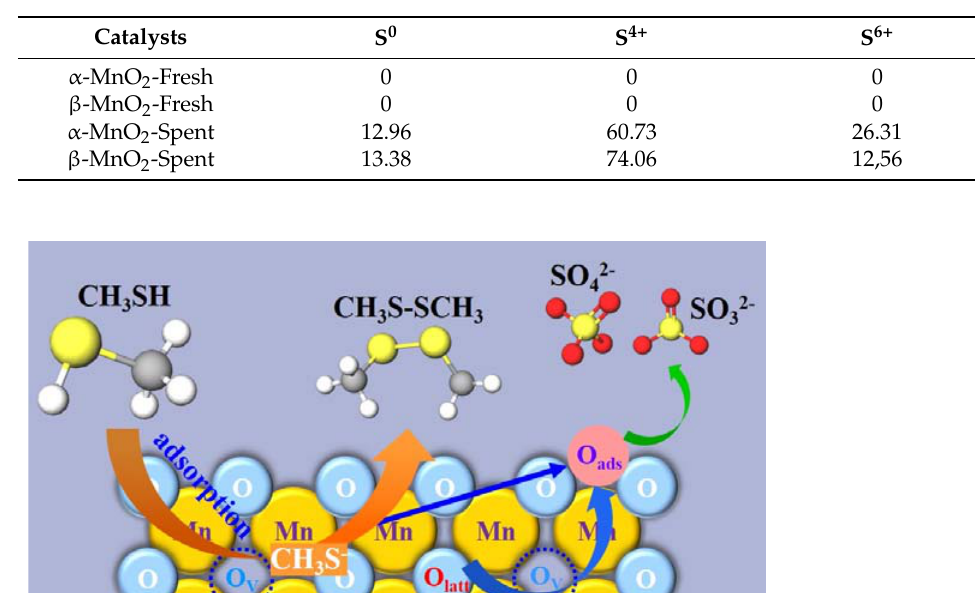
Figure 13. XPS profiles of S 2p over the fresh ( A ) and spent ( B ) catalysts. Table 3. S 2p results before and after the reaction of B-MnO 2 and C-MnO 2 .